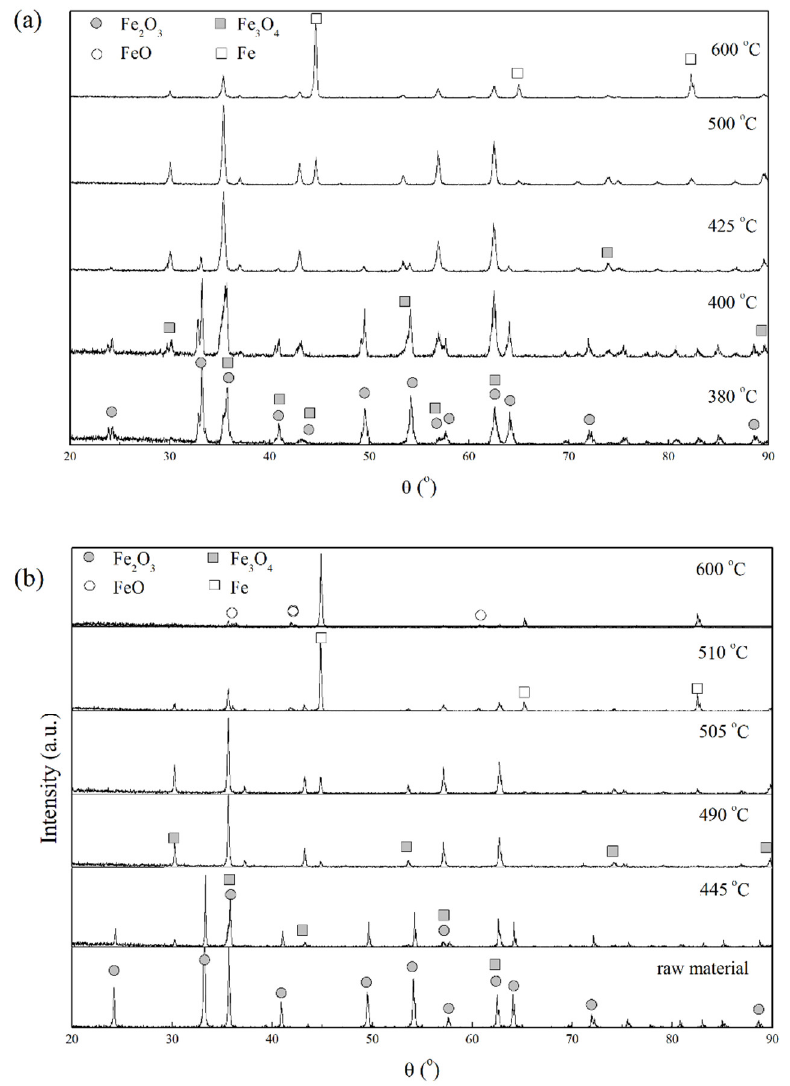
Figure 1. X-ray diffraction patterns of samples reduced partially by pure hydrogen at heating rates of ( a ) 10 and ( b ) 20 °C/min.